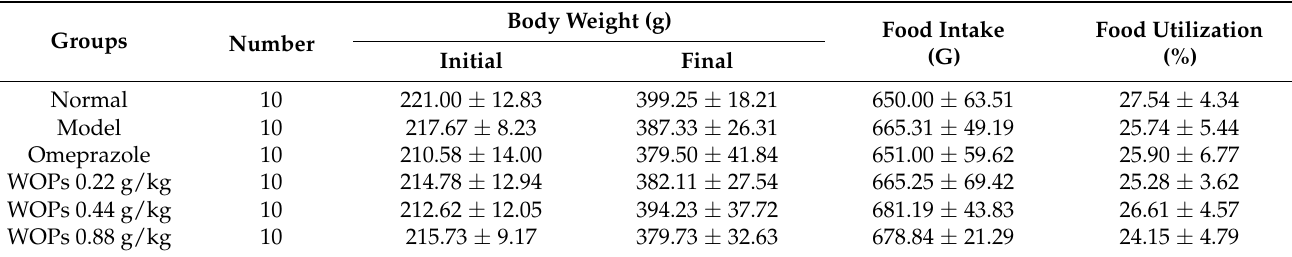
Table 1. Effects of WOPs on body weight, food intake, and food utilization in